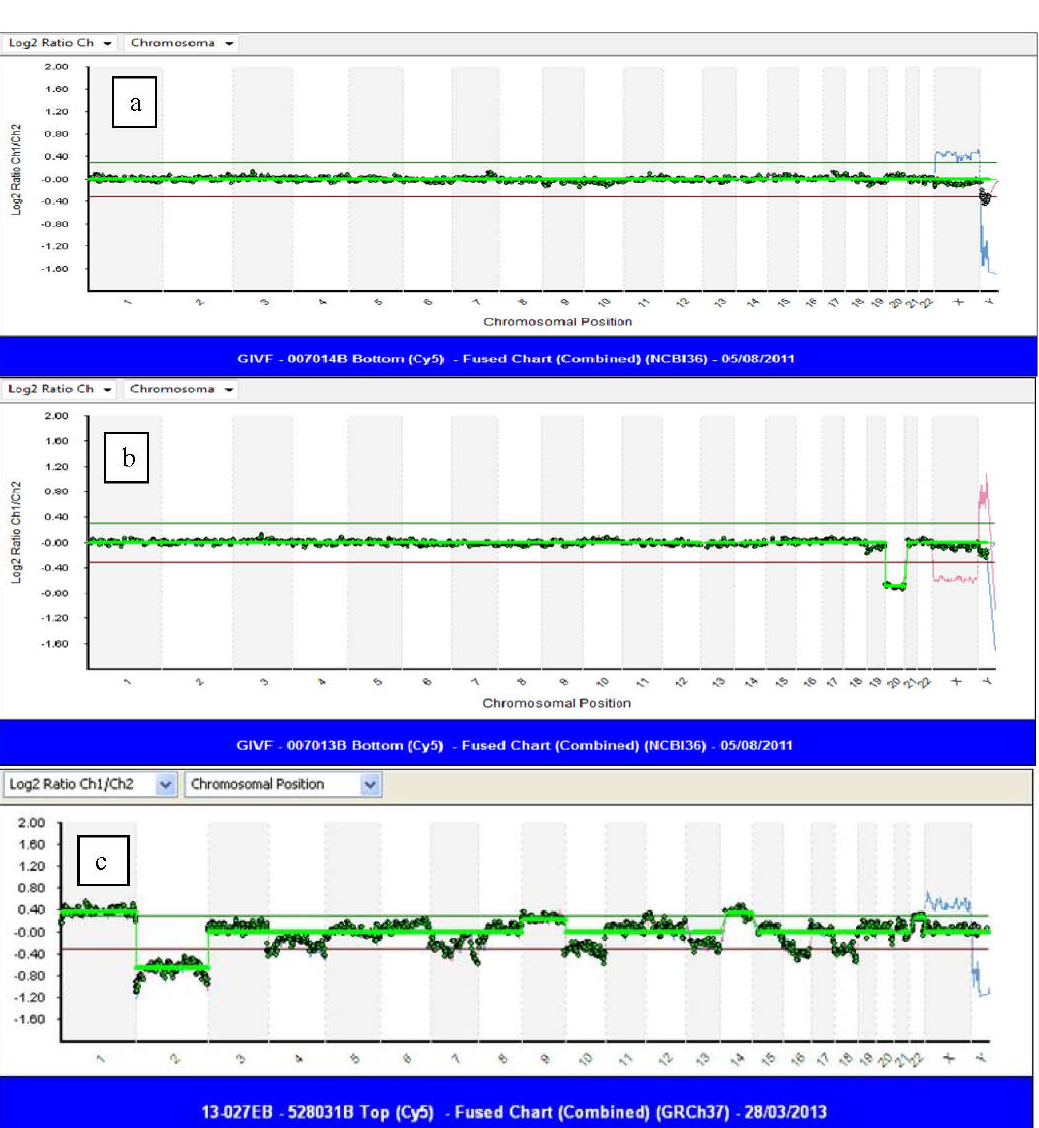
Figure 2. Array comparative genomic hybridization (aCGH) tracing after trophectoderm biopsy: ( a ) normal male embryo (female embryo control in blue); ( b ) female embryo with monosomy for chromosome 20 (male control in red); ( c ) an excellent quality blastocyst showing chaotic chromosome abnormalities. Nearly every chromosome is